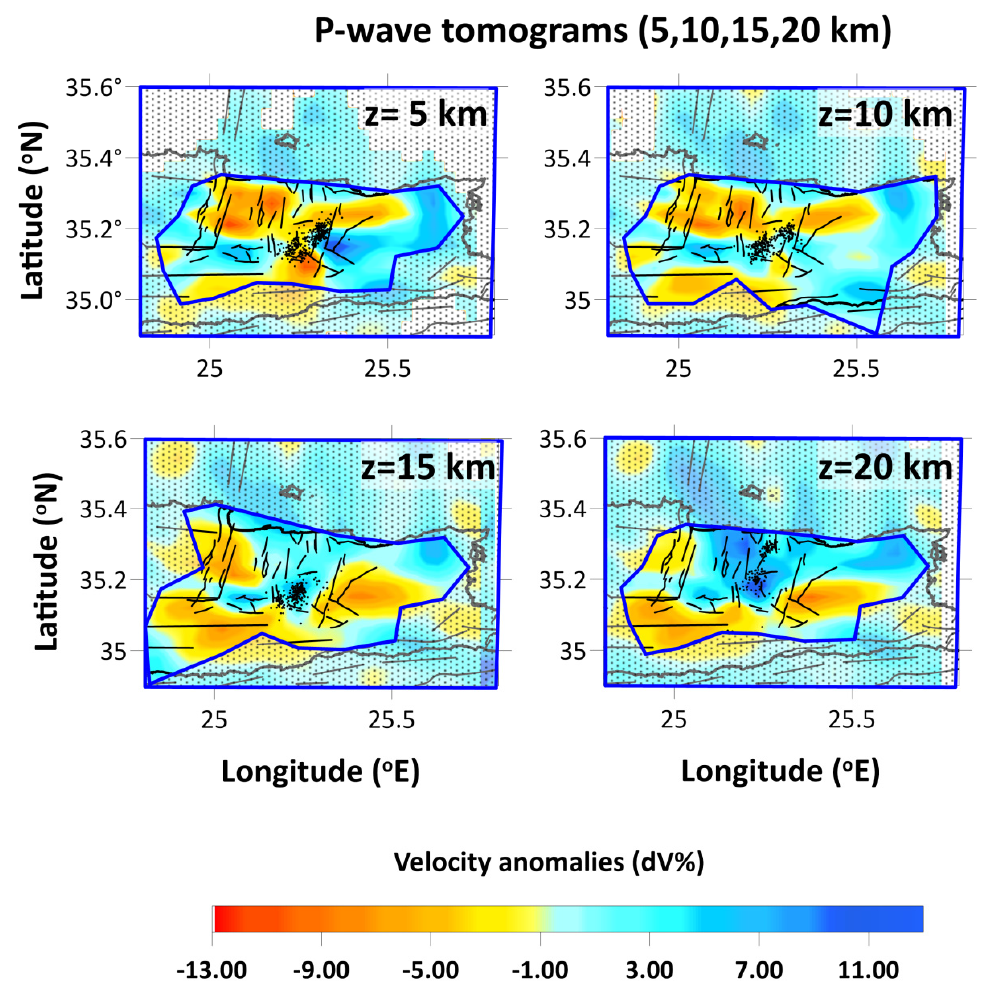
Figure 6. Lateral V P (%) perturbations at 5, 10, 15, and 20 km depths. Areas with lower resolution are masked (darkened). Fault traces derived by [31].